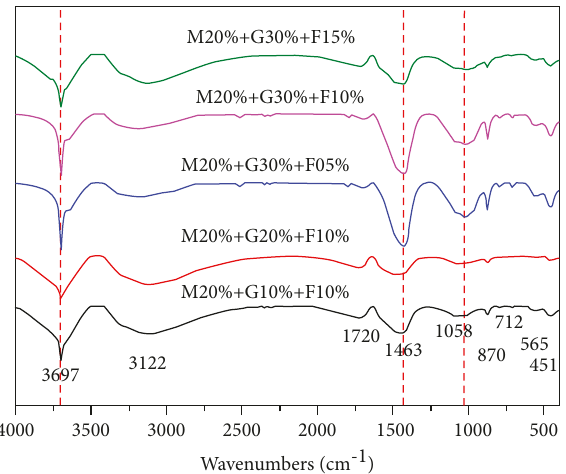
Figure 5: FTIR pattern of bio-carbonated RMC-based WDC samples after 28 days of curing.